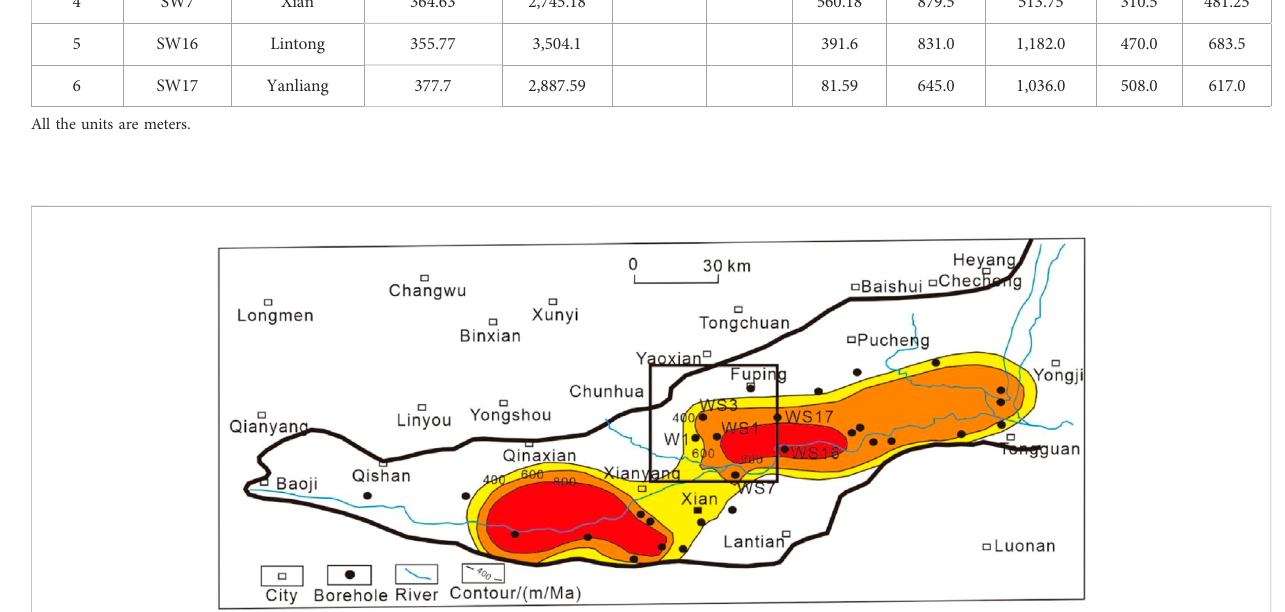
FIGURE 9 Standard borehole detection and Quaternary stratigraphy contour map in the Weihe basin. We have marked the abbreviations of six standard boreholes consistent with Table 4.The thickblack solidlinerepresents thebasinboundary,andtheblack rectangle indicatestheextentof thestudy area.